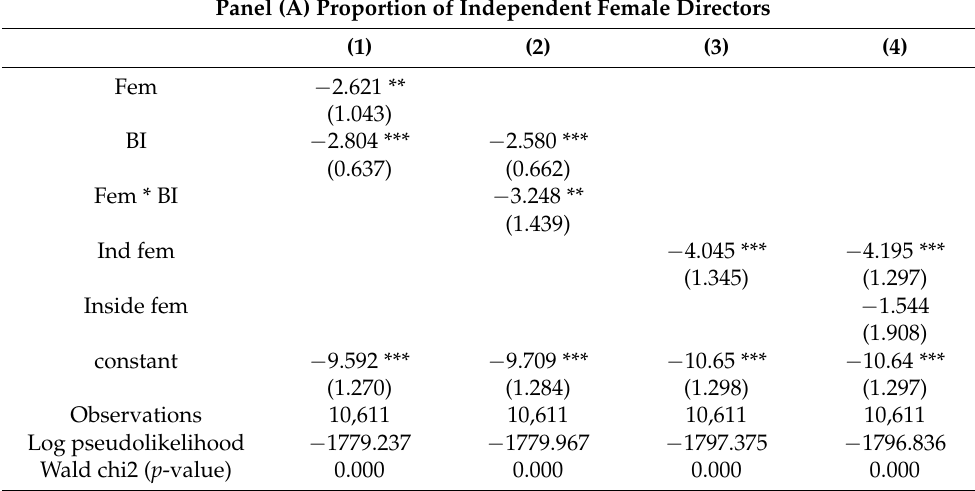
Table 11. Independent female directors and financial fraud. (p-score